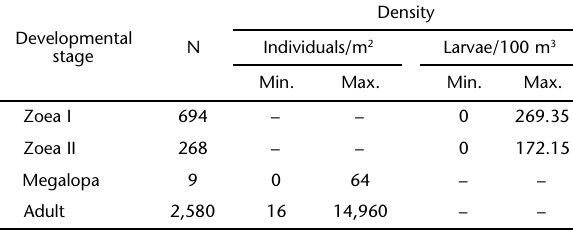
Table I. Abundance and density of P. armatus at different stages of development recorded in the Marapanim Estuary, Pará (Brazil), between August 2006 and July